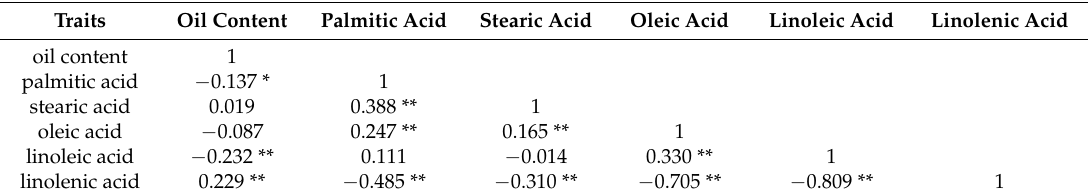
Table 3. Correlation among oil content and fatty acids of E. ulmoides seed.